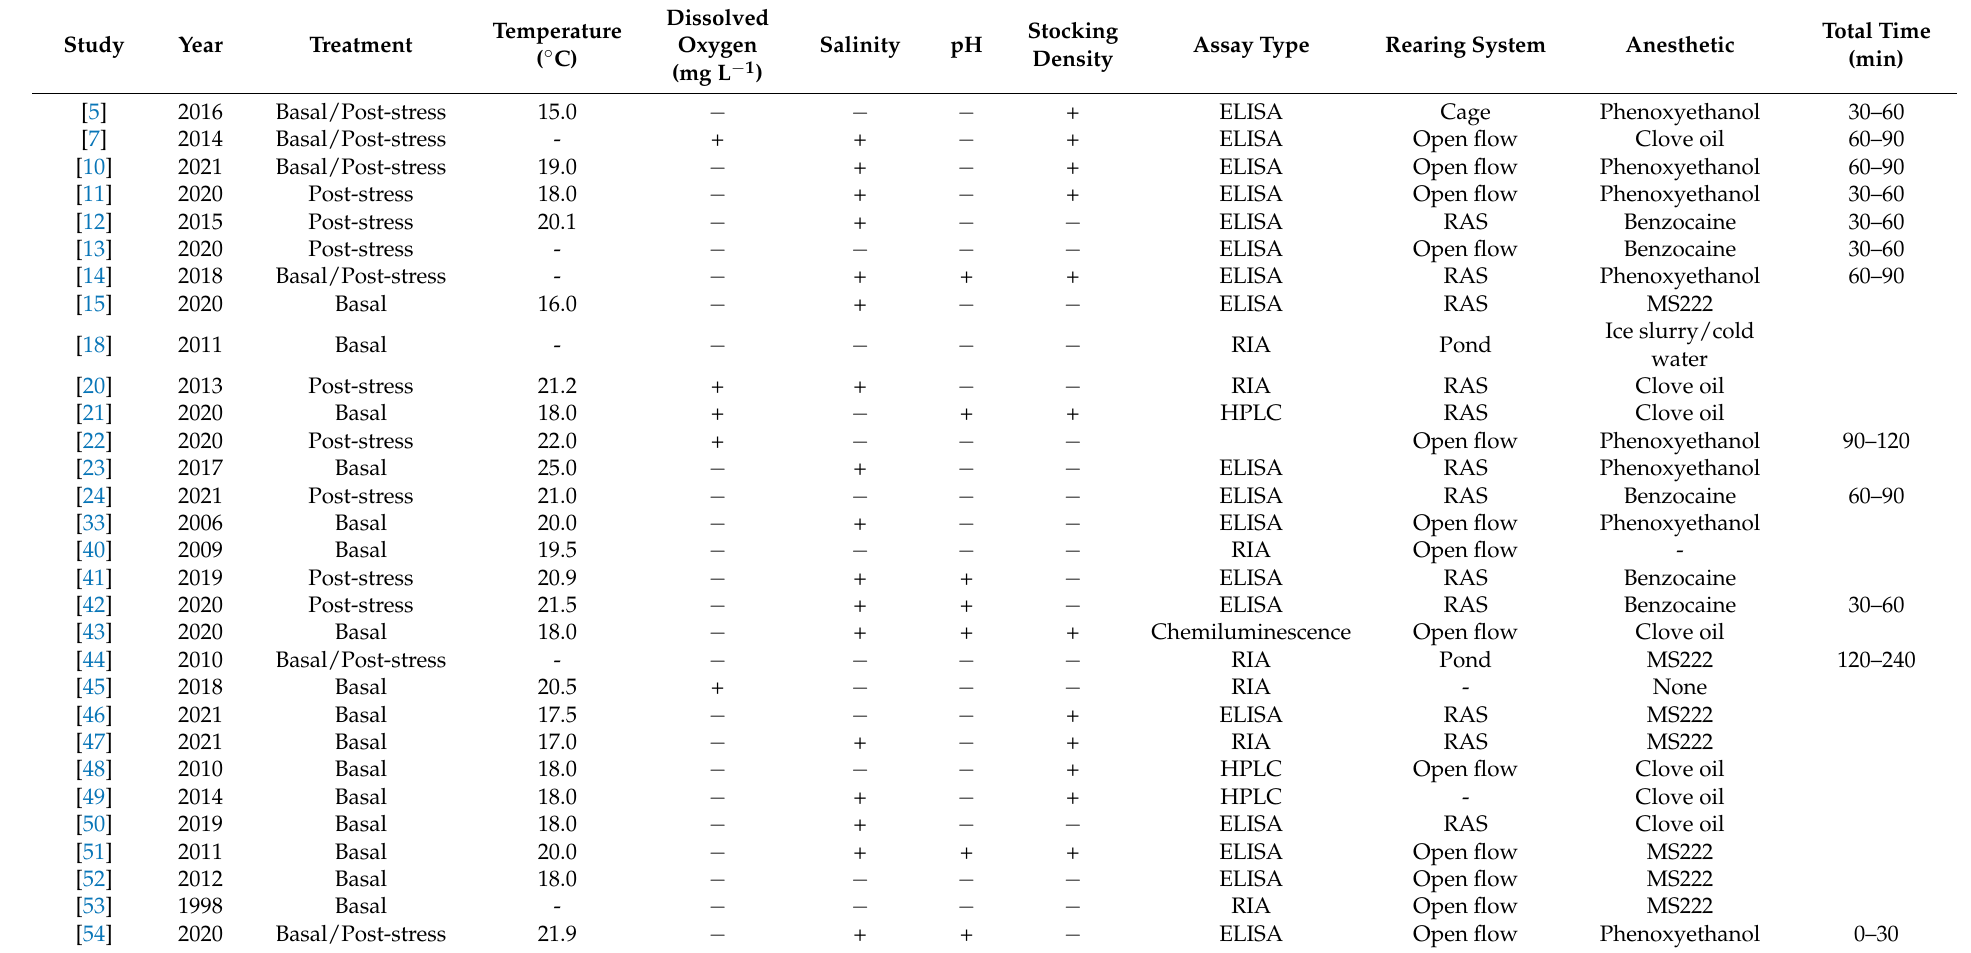
Table 2. Studies included in the meta-analysis ( n = 69). In Dissolved oxygen, Salinity, pH, and Stocking density a “+” symbol signifies the presence, while a “ − “ symbol the absence of information in the respective